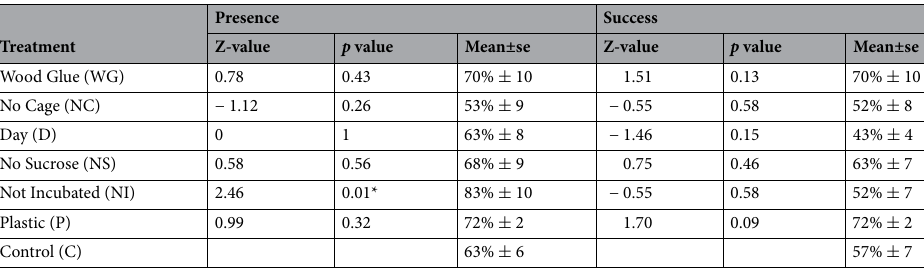
Table 3. Glmm results for models analyzing the fixed effect of treatment on presence and success during the destructive sampling (day 14), where treatments are compared to the Control group. Asterisk denotes statistical significance with respect to the control group ( α = 0.05 ), alongside mean and se for presence and success.